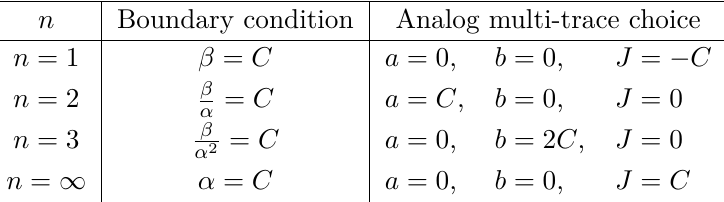
Table 1 . Matching between the boundary conditions obtained from the multi-trace deformation boundary action (3.3) and those obtained from the boundary term